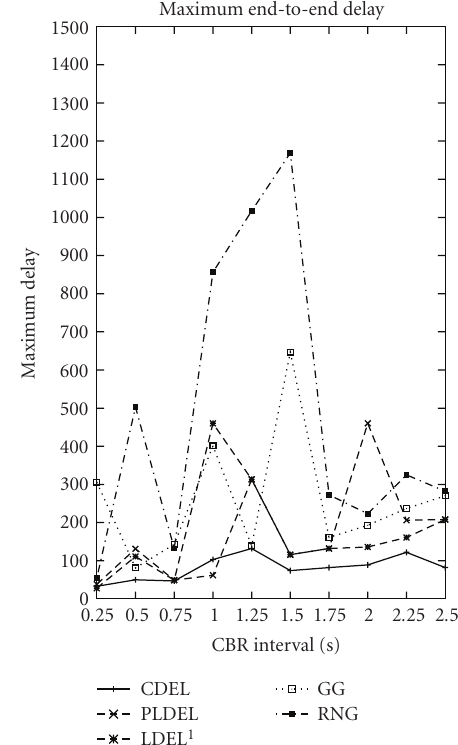
Figure 12: Maximum delay in μ sec.